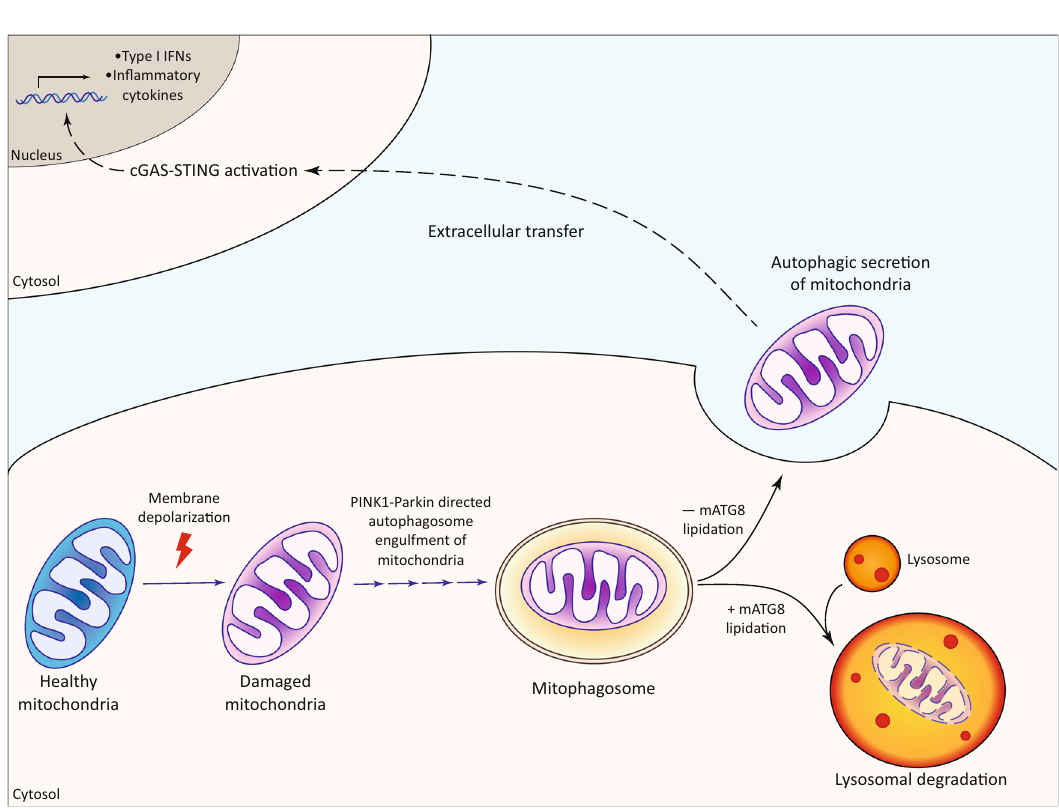
Fig. 8 Graphic summary of Autophagic Secretion of Mitochondria (ASM). Damaged mitochondria are cleared from cells via Autophagic Secretion of Mitochondria (ASM) in the absence of mATG8-conjugation. Extracellular mitochondria can activate the cGAS – STING innate immune pathway in recipient cells, thereby promoting an in fl ammatory